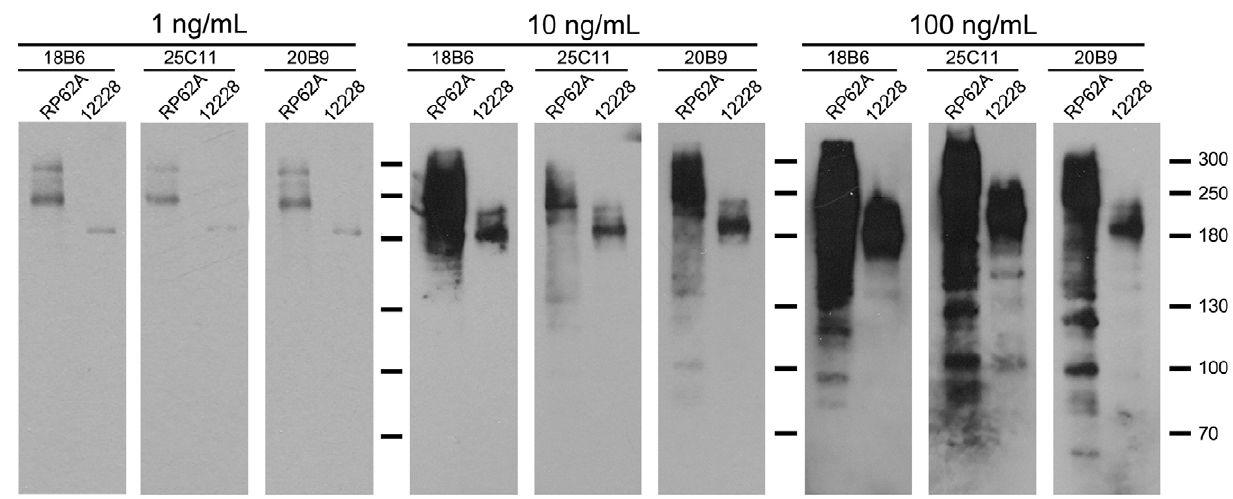
Figure 1. Antigenic specificity of the MAbs. The antigenic specificities of the MAbs at 1 ng/mL and at higher concentrations (10 ng/mL, 100 ng/ mL) against proteins in supernatants of lysostaphin-treated S. epidermidis RP62A (‘‘RP62A’’) and ATCC 12228 (‘‘12228’’) were analyzed using Western blot. The multiple proteins (between 250 kDa–300 kDa) in S. epidermidis RP62A, or the single protein (180 kDa) in S. epidermidis ATCC 12228, probed by 1 ng/mL MAbs, corresponded to full-length or proteolytically processed Aap, based on an analysis of these bands using a 4700 MALDI-TOF/TOF proteomics analyzer (Applied Biosystems, http://www.appliedbiosystems.com).